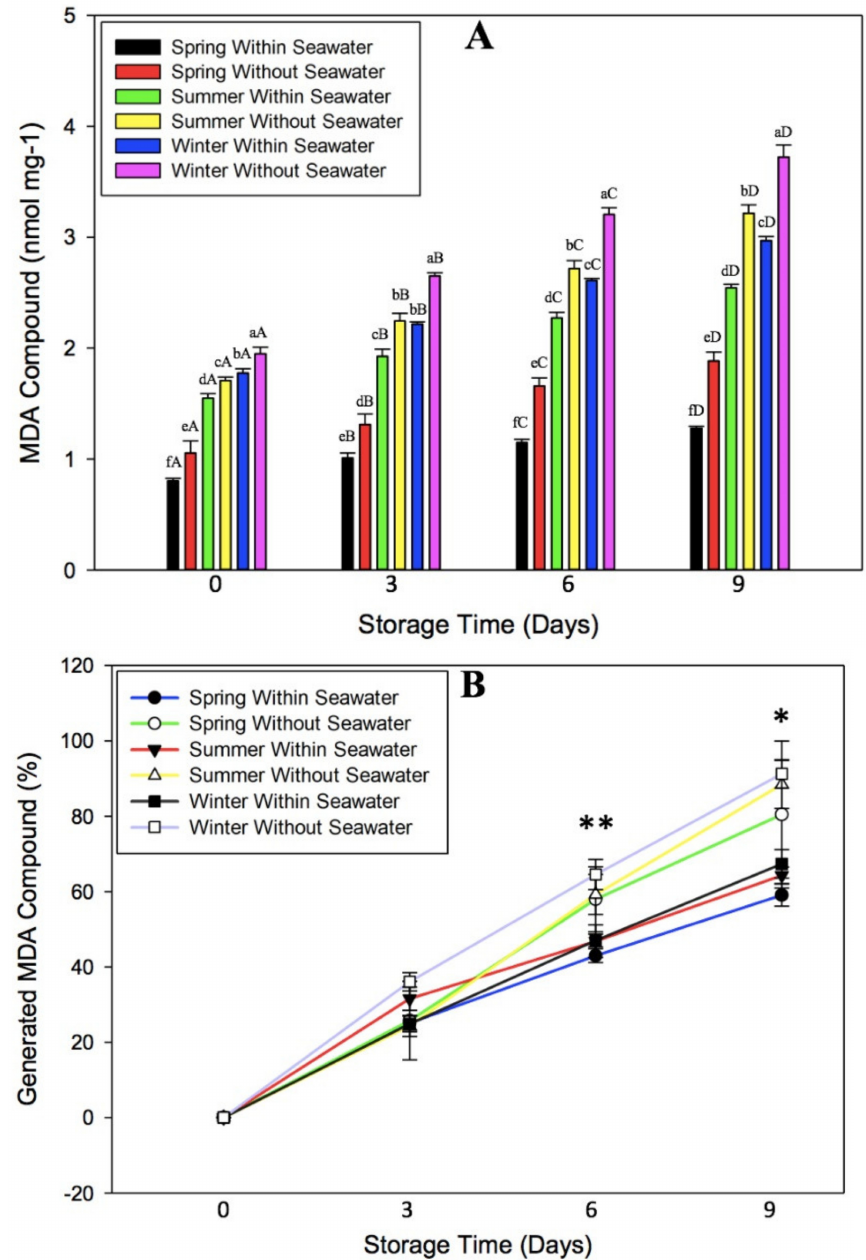
Figure 3. Oxidative stress effect on malondialdehyde (MDA) compound of seagrape in different seasons during post-harvest storage ( A ) MDA compound ( B ) generated MDA compound rates. The data express means ( n = 3) with the error bar shows standard deviation. a–f Means express the significant differences in the same storage time ( p < 0.05). A–D Means express the significant differences in the same treatment ( p < 0.05). The star marks express the significant differences as respectively * ( p < 0.05), and ** ( p <